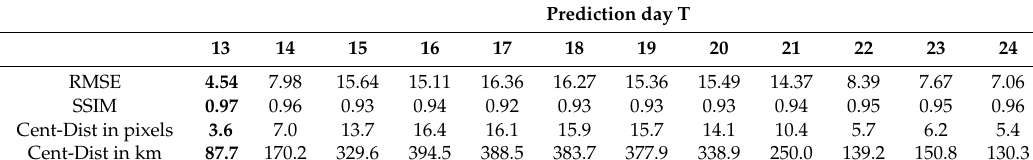
Table 15. Daily comparison of RMSE, SSIM, and centroid distance of case 9.